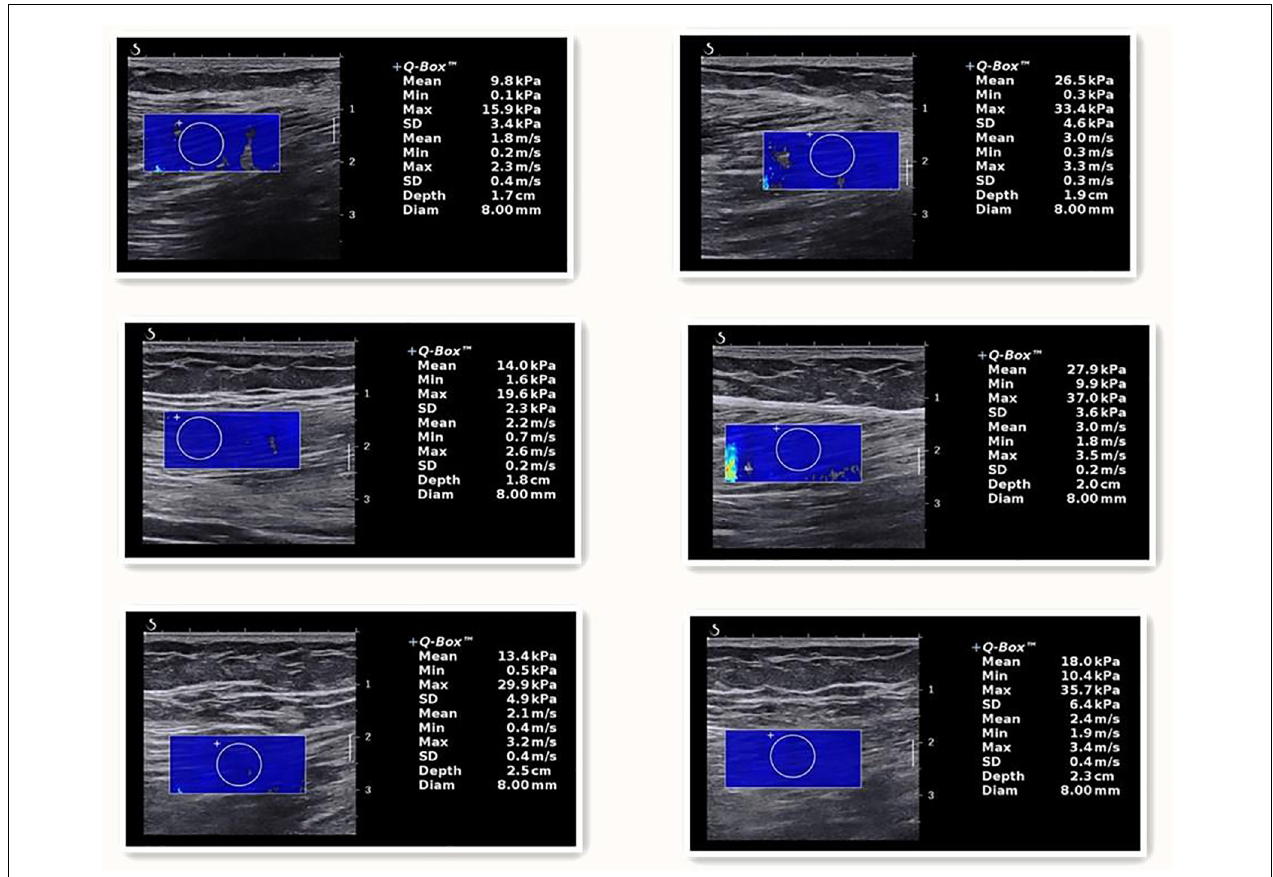
FIGURE 1 | The one on the left is listed as a healthy person, and the SM, ST, and BFL are listed from top to bottom. The one on the right is a patient, and the SM, ST, and BFL are listed from top to bottom.